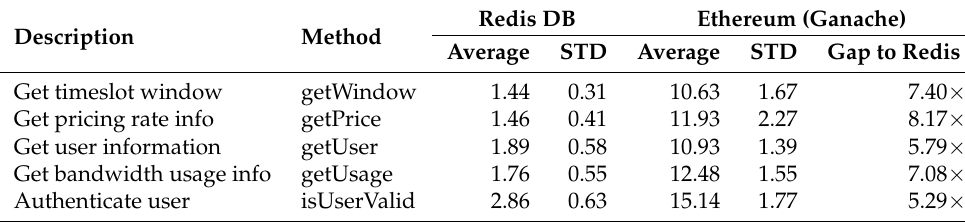
Table 9. Processing delay (in milliseconds) for read-only operations in RealPrice when implemented as non-blockchain (Redis DB) and blockchain (Ganache)